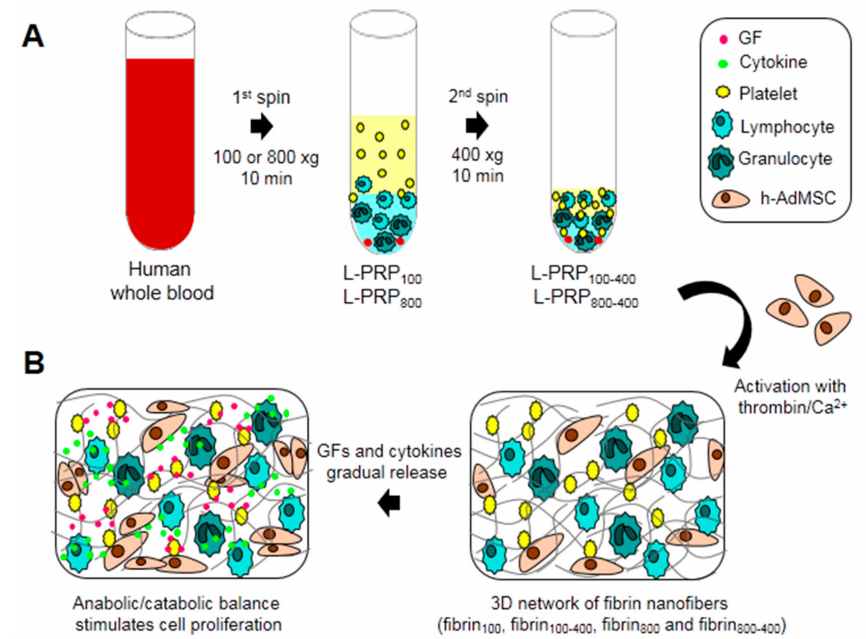
Figure 1. Schematic illustration of the experimental design. ( A ) Human whole blood was collected and centrifuged at 100 and 800 × g for 10 min to form L-PRP 100 and L-PRP 800 . These L-PRPs were submitted to a second spin at 400 xg for 10 min to form L-PRP 100-400 and L-PRP 800-400 after the removal of 70% of the supernatant; ( B ) h-AdMSCs were resuspended in each L-PRP, followed by the formation of a fibrin nanofiber network after activation with thrombin / Ca 2 + . Activated platelets and leukocytes secrete GFs and cytokines that in an appropriate balance stimulate cell